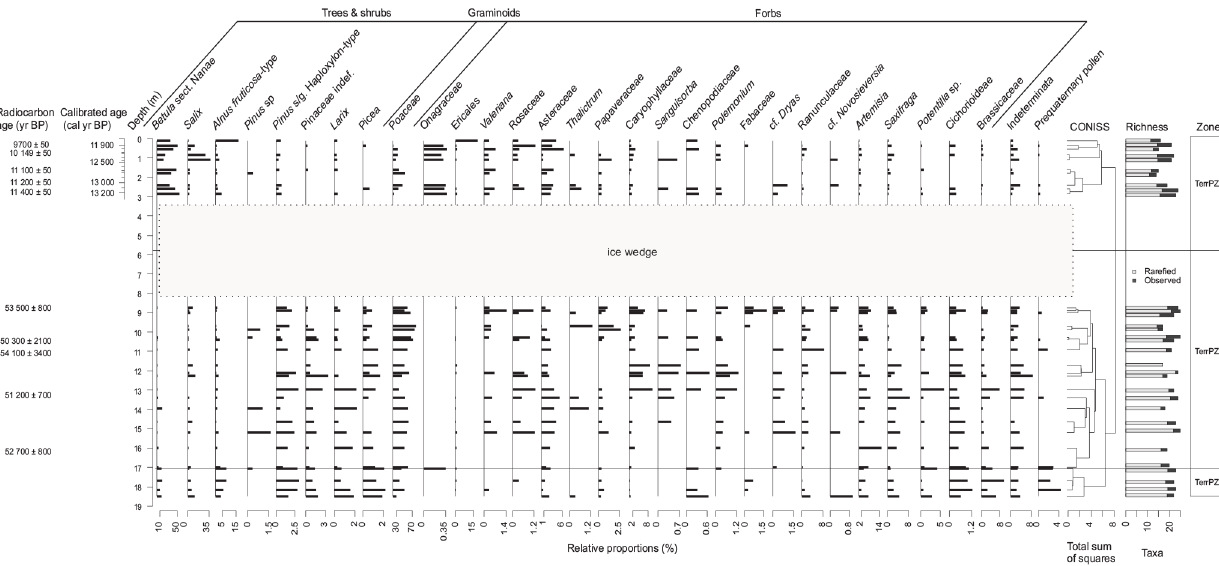
Figure 6. Stratigram of terrestrial pollen (subset for statistical analyses) with relative proportions in percentage of the taxa in each sample as horizontal bars, CONISS dendrogram, observed (dark grey) and rarefied (light grey) taxonomic richness. Uncalibrated radiocarbon ages are given with standard error in years before present (yrBP) and calibrated ages from the age–depth model in calendar years before present (calyrBP). The grey area indicates the ice wedge where no samples were taken. Horizontal lines indicate borders between palynological zones. Scaling is taxon-specific for better visibility of low